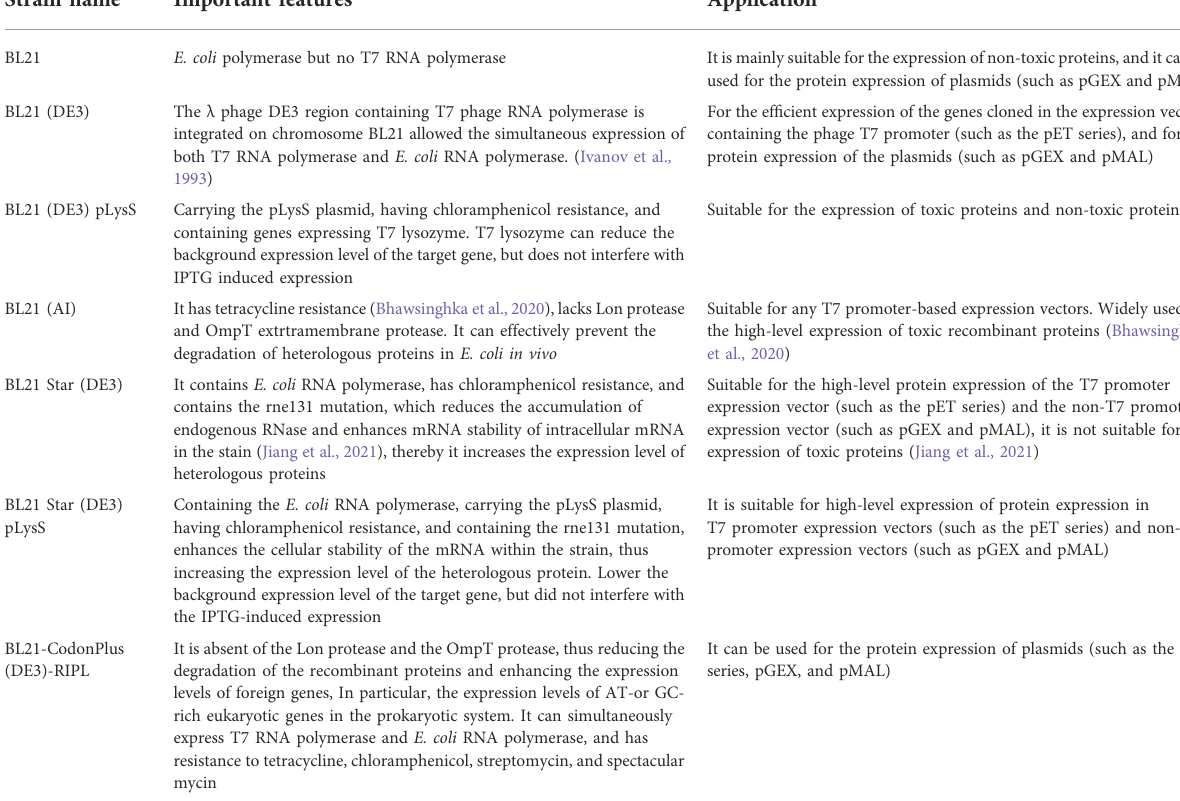
TABLE 4 E. coli BL21 and its derived host for recombinant protein